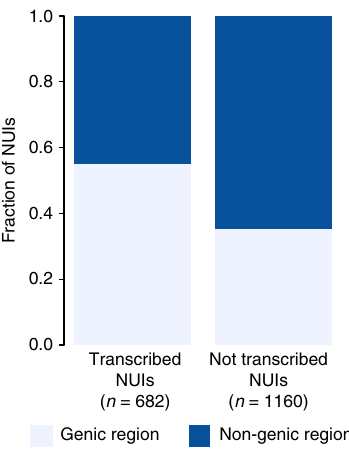
Fig. 4 Characterization of non-reference unique insertions in the transcriptome. Stacked bars representing the proportions of NUIs that are either in the genic or non-genic regions of the genome (Fisher p = 8.12e − 17, OR = We randomly selected 50 individuals representing two super- populations (Europeans and Africans) and extracted RNA-Seq reads not mapped to the human reference genome. We realigned the unmapped RNA-Seq reads to our dataset to identify NUI bearing transcribed sequences (Methods). From the Geuvadis RNA-Seq data, we identi fi ed 643 trancribed NUIs (35%), among which 90 overlapped with the result from the human dbEST. This overlap of transcribed NUIs is statistically signi fi cant (Fisher ’ s p = 8.018409e − 17; OR = 4.83). In total, 682 NUIs are transcribed and more than half are located in the genic region of the human genome (Fig. 4; Fisher p = 8.12e − 17, OR = 2.26). Comparison with the Icelandic deCODE Genetics dataset .